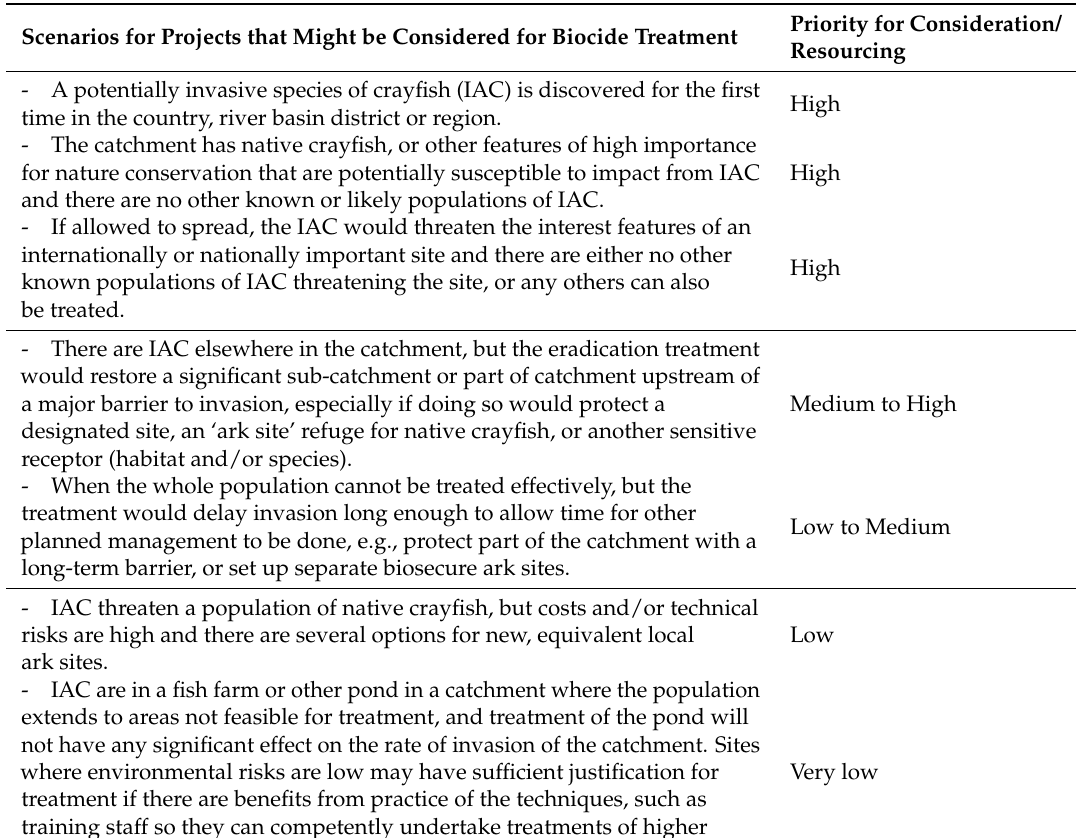
Table 8. Recommendations on how to prioritise possible biocide treatment of invasive alien crayfish